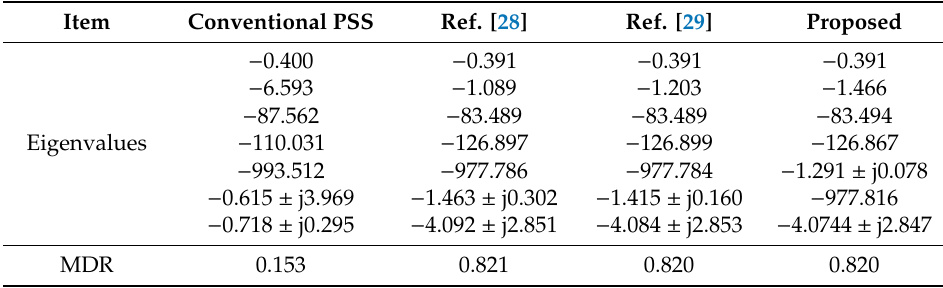
Table 12. Eigenvalues and MDR comparison for the operating situation # 5 (second